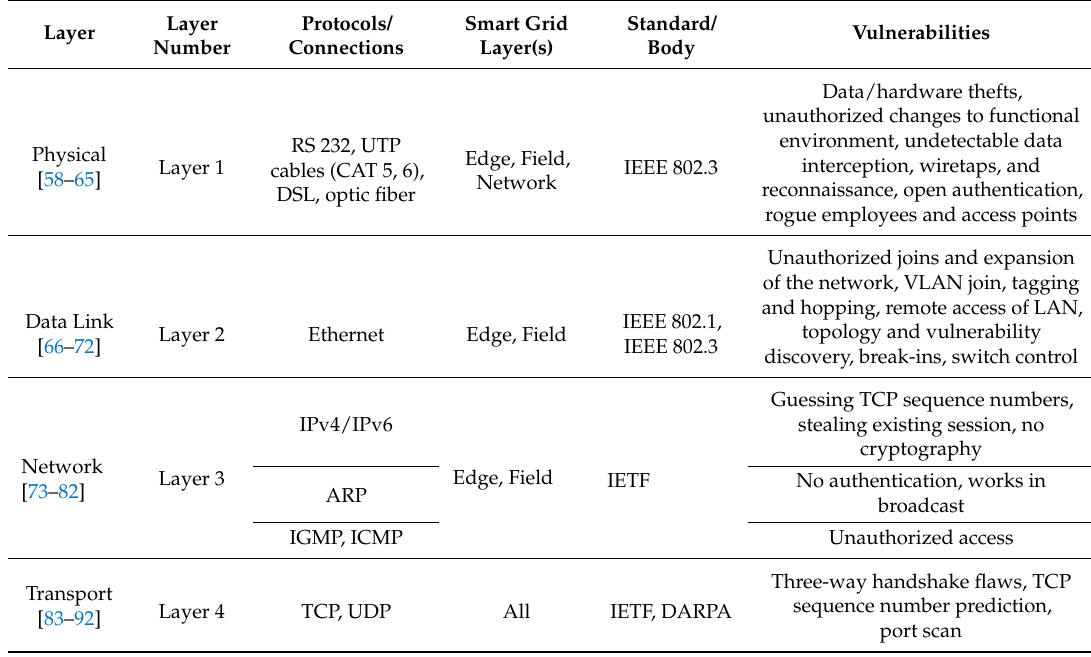
Table 1. A Summary of DER Communication-Level Vulnerabilities Layers